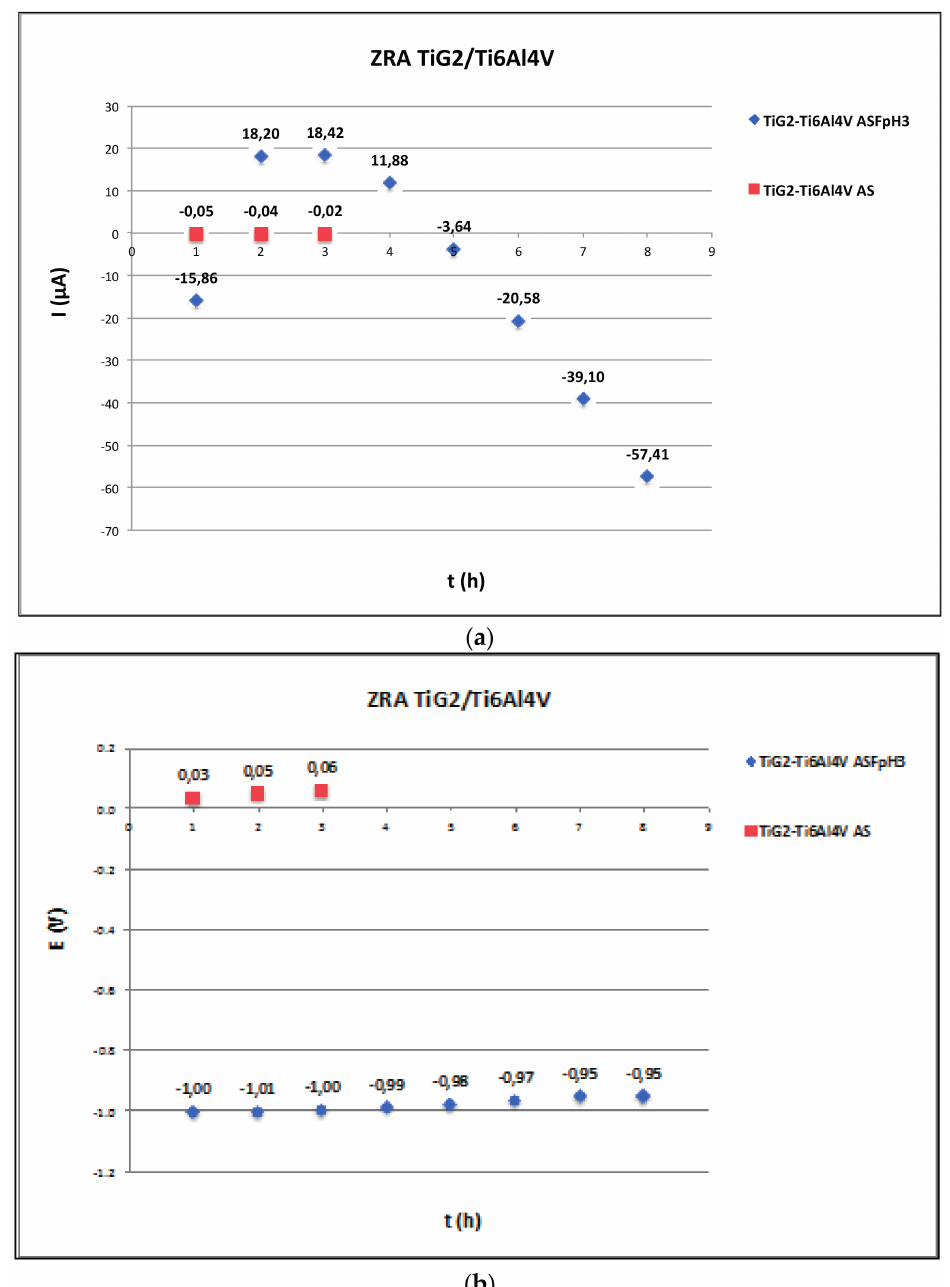
Figure 6. Average values at the end of every hour of immersion of the ( a ) galvanic current and ( b ) galvanic potential of the TiG2/Ti6Al4V pair in AS and ASF − pH3 as a function of time. Legend: Au: gold-palladium alloy; CoCr: cobalt-chromium alloy; CoCr-c: cobalt-chromium cast alloy; NiCrTi: nickel-chromium-titanium alloy; Ti64: Titanium-6Aluminium-4Vanadium Titanium alloy); TiG2: Titanium grade 2; rep: repetition of the